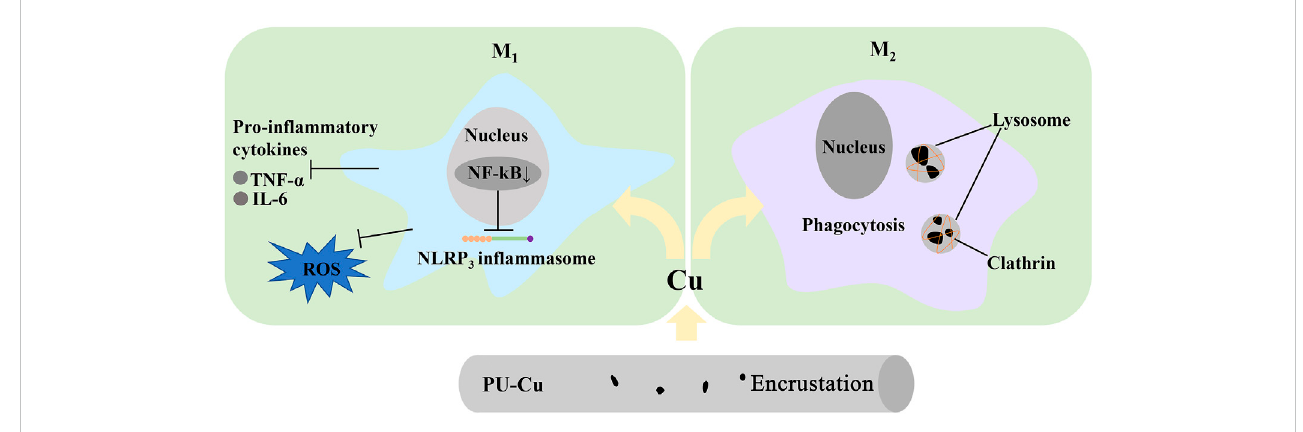
FIGURE 9 Schematic diagram of Cu-bearing stents, inhibiting encrustation via